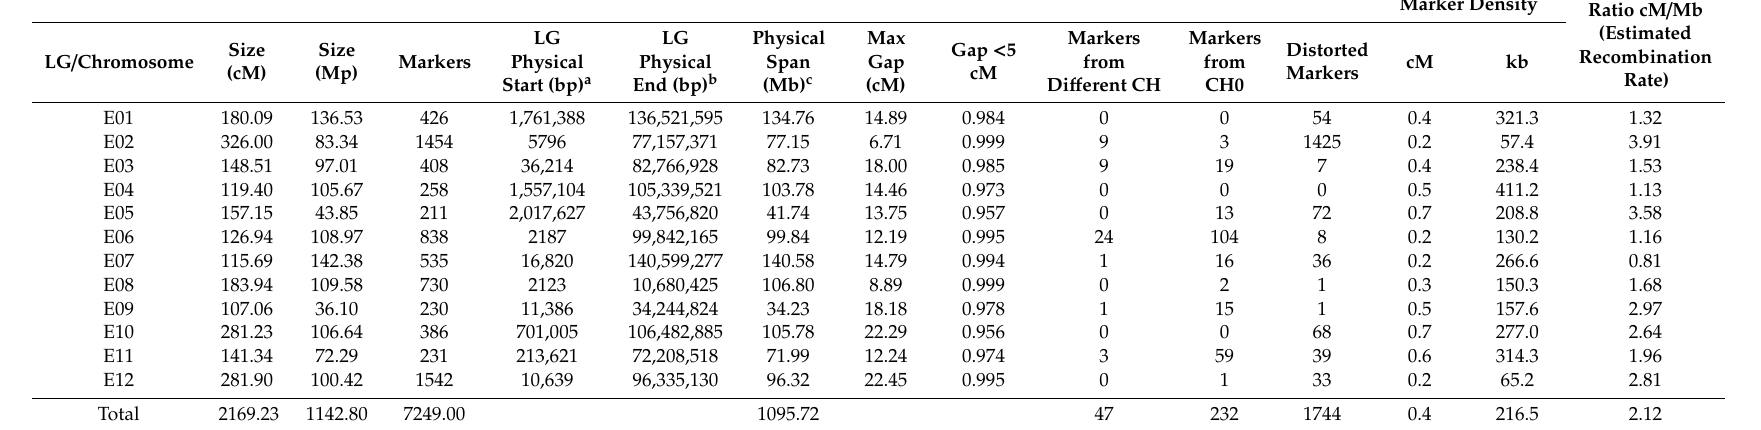
Table 2. Parameters associated with the framework eggplant genetic map. a,b The overall physical start and end positions of all markers of each linkage group. c The distance between the linkage group (LG) physical start and LG physical end indicates the overall physical span of all the markers of each linkage group in a particular